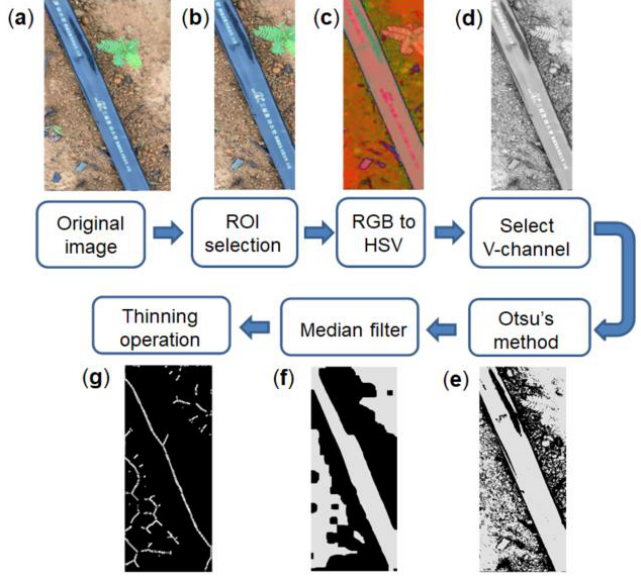
Figure 5. Drip tape extraction process: ( a ) Original image; ( b ) ROI image; ( c ) HSV image; ( d ) V-channel; ( e ) Otsu’s binarization method; ( f ) median filter; ( g ) thinning operation. For an image with a uniform gray distribution, the larger the variance value was, the larger the difference was between the two parts in the image. Otsu’s method utilized the maximum interclass variance that was relatively common as a measure of classification criteria. This method was used to separate the background and objects in the V-channel of the HSV image (see Figure 5d). Using threshold segmentation to maximize the